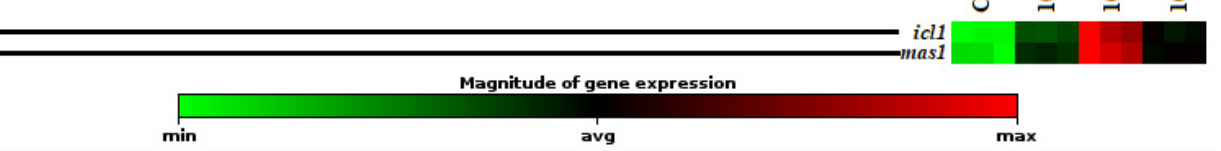
Figure 2. Effect of progesterone on the gene expression of isocitrate lyase ( icl1 ) and malate synthase ( mas1 ) in the endosperms of 4-day-old maize seedlings. The clustergram performs non-supervised hierarchical clustering of the entire dataset to display a heat map with dendrograms indicating co-regulated genes across groups.